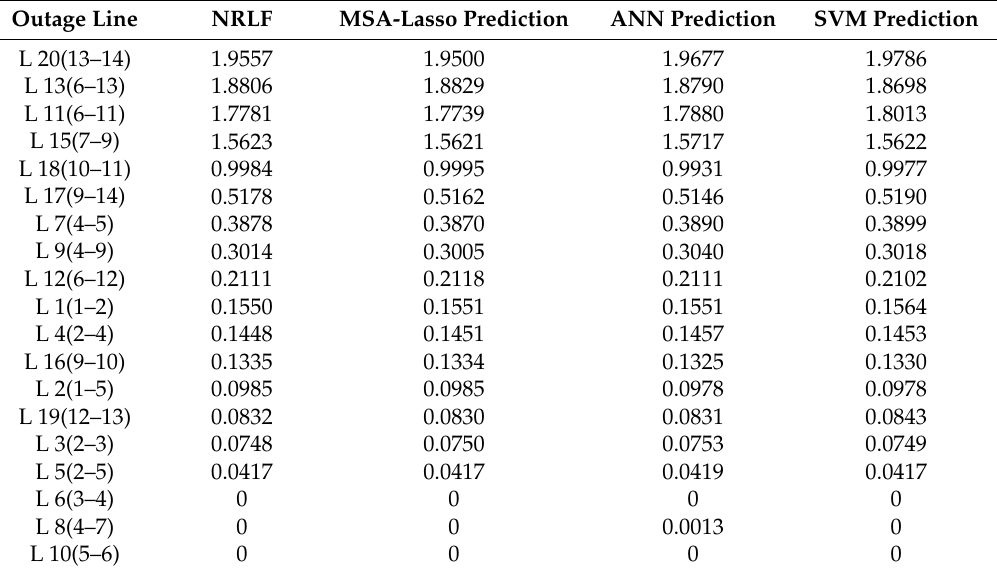
Table 10. Security index results of each method in the light load condition of the IEEE 14-bus system.